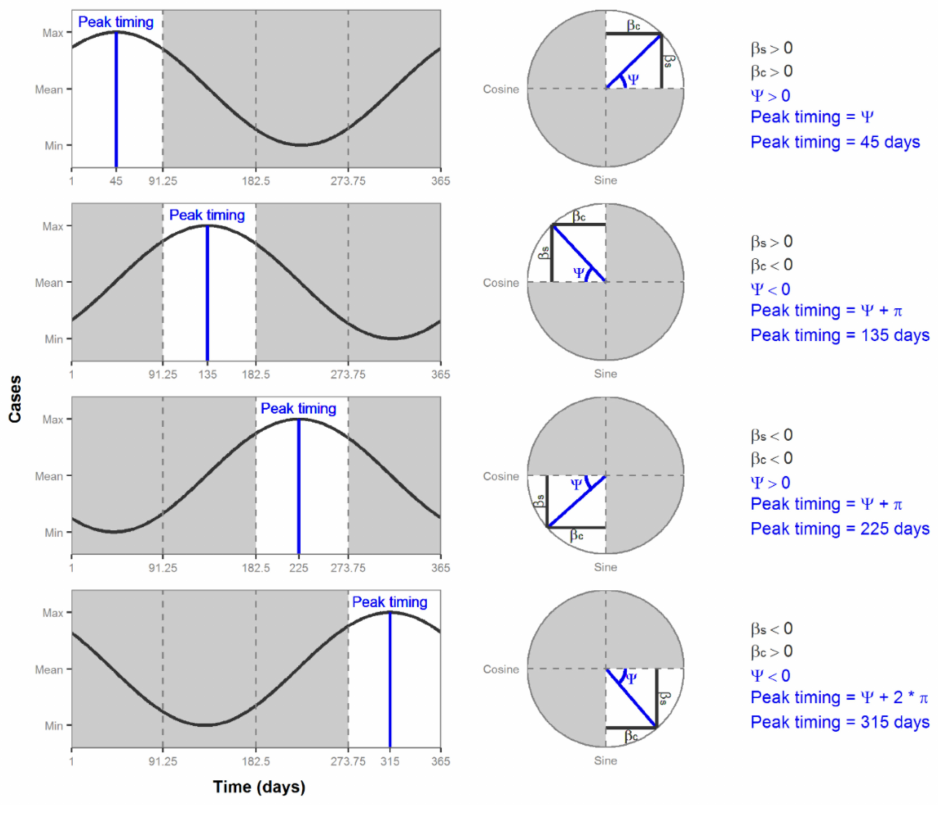
Figure 7. Peak timing plots and formulas for four quadrants.